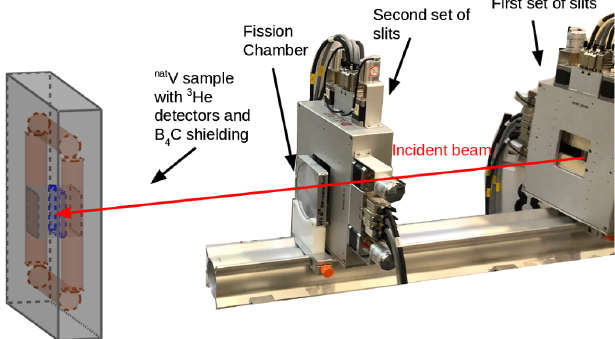
FIG. 4. Experimental setup on the beam line at V17. The incident beam (red) passes from the right to the left through two sets of (x,y) slits and a fission chamber before striking the nat V sample